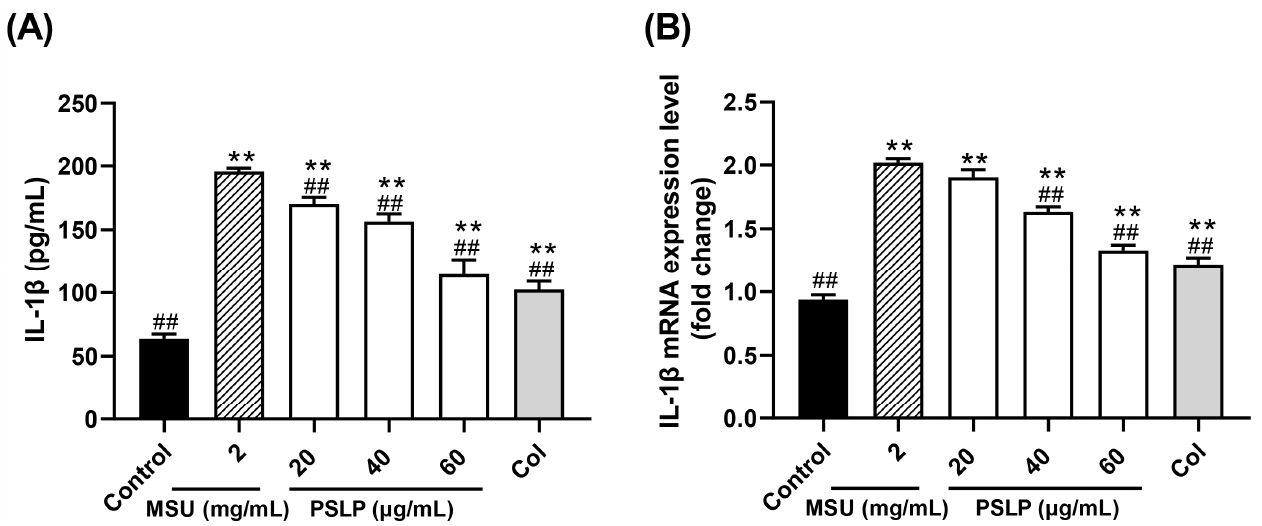
Figure 2. Effect of PSLP on IL-1 β secretion ( A ) and its mRNA expression level ( B ) in MSU-stimulated RAW264.7 cells. The values were expressed as means ± SD ( n = 3), ** p < 0.01 vs. the control group. ## p < 0.01 vs. the MSU group.